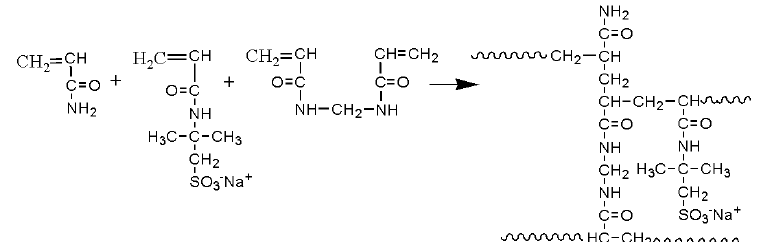
Figure 3. The synthesis equation of XN-T.